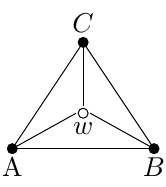
(cid:10) P y (cid:10) P y ) A B C